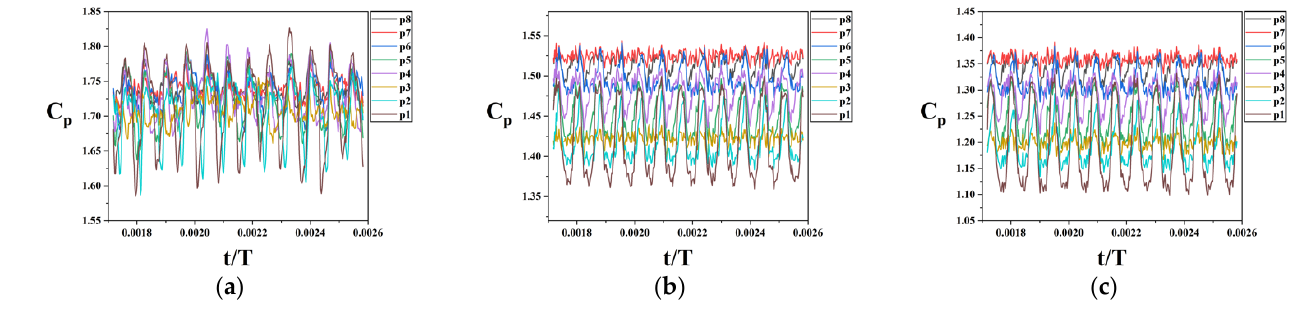
Figure 18. Pressure pulsations for Condition 1 at constant 0.5 Q d ( a ), Q d ( b ), and1.25 Q d ( c ).